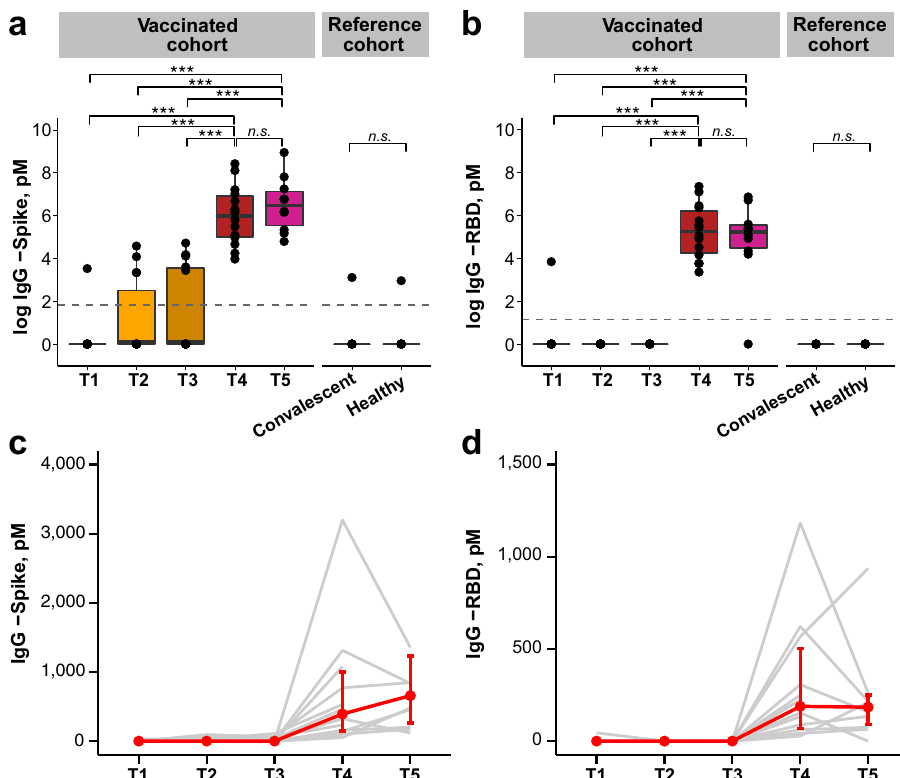
Fig. 2 SARS-CoV-2-speci fi c IgG antibodies in human milk samples. Concentration [pM a ] of IgG antibodies against spike ( a ) and RBD ( b ) in human milk for vaccinated women ( n = 14) across timepoints T1 – T4, with ( n = 10) at T5; convalescent ( n = 6) and healthy women ( n = 9) used as reference cohort. Gray dotted lines re fl ect the limit of assay detection. p values were calculated with Kruskal – Wallis test and Dunn ’ s post hoc test, * p < 0.05, ** p < 0.01, *** p < 0.001, n.s. non-signi fi cant. Box and whiskers plots show median (center line), interquartile range (box), and 10th and 90th percentiles (whiskers). Increase in IgG antibodies against spike ( c ) and RBD ( d ) over time. Line plots show the median, and error bars show the fi rst and third quartiles. Each line in gray represents data from one individual and the median ± IQR is represented in red. RBD receptor-binding domain, IgG immunoglobulin G, pM picomolar, IQR interquartile range, T1 pre-vaccination, T2 1 – 3 days after dose 1 of BNT162b2 vaccine, T3 7 – 10 days after dose 1 of BNT162b2 vaccine, T4 3 – 7 days after dose 2 of BNT162b2 vaccine, T5 4 – 6 weeks after dose 2 of BNT162b2 vaccine. a SI conversion factors: to convert concentration from pM to M, multiply values by 10 12